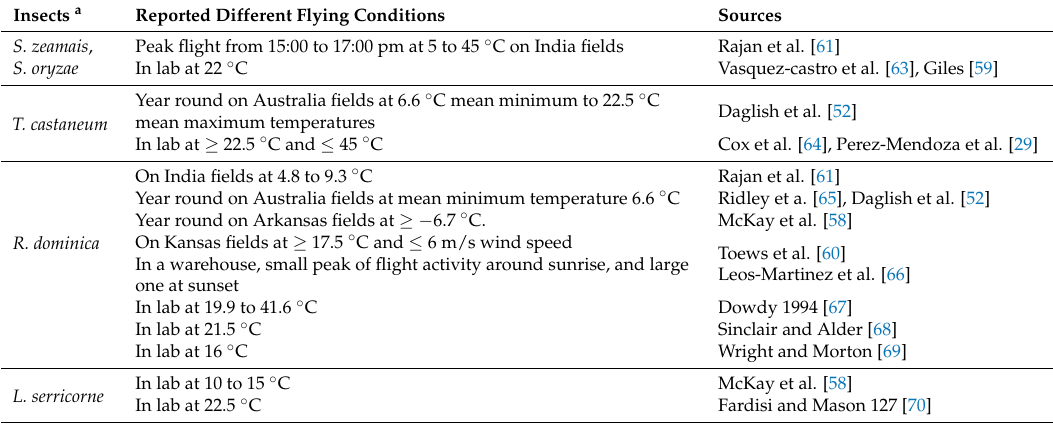
Table 2. Different weather conditions reported when flying insects are